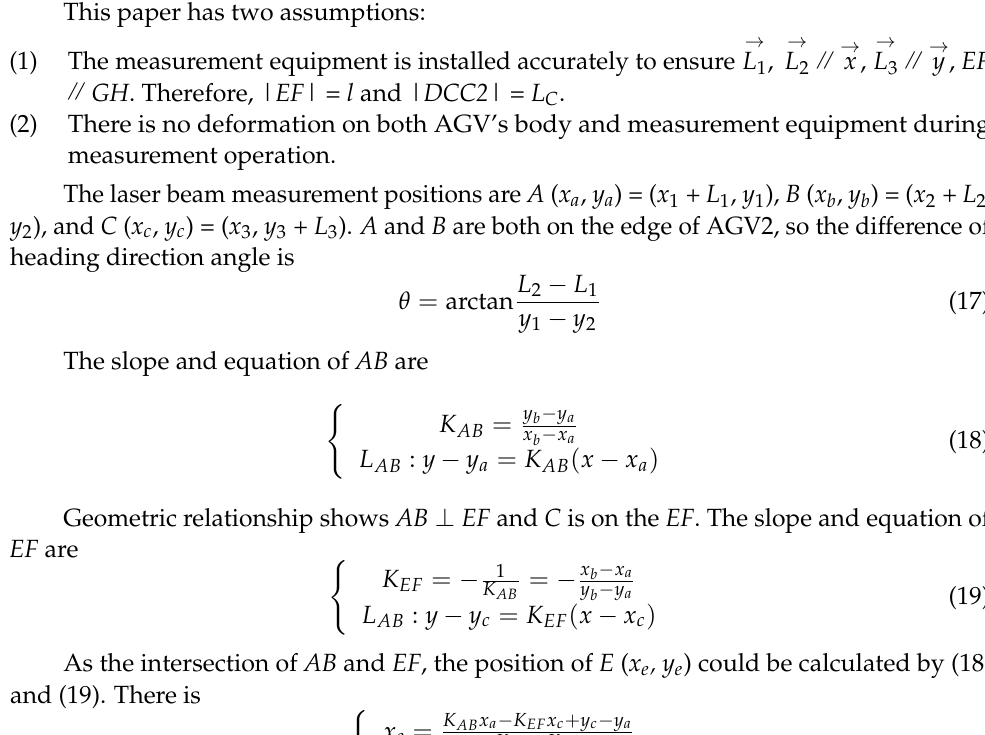
Figure 10. Experiment AGV system architecture.